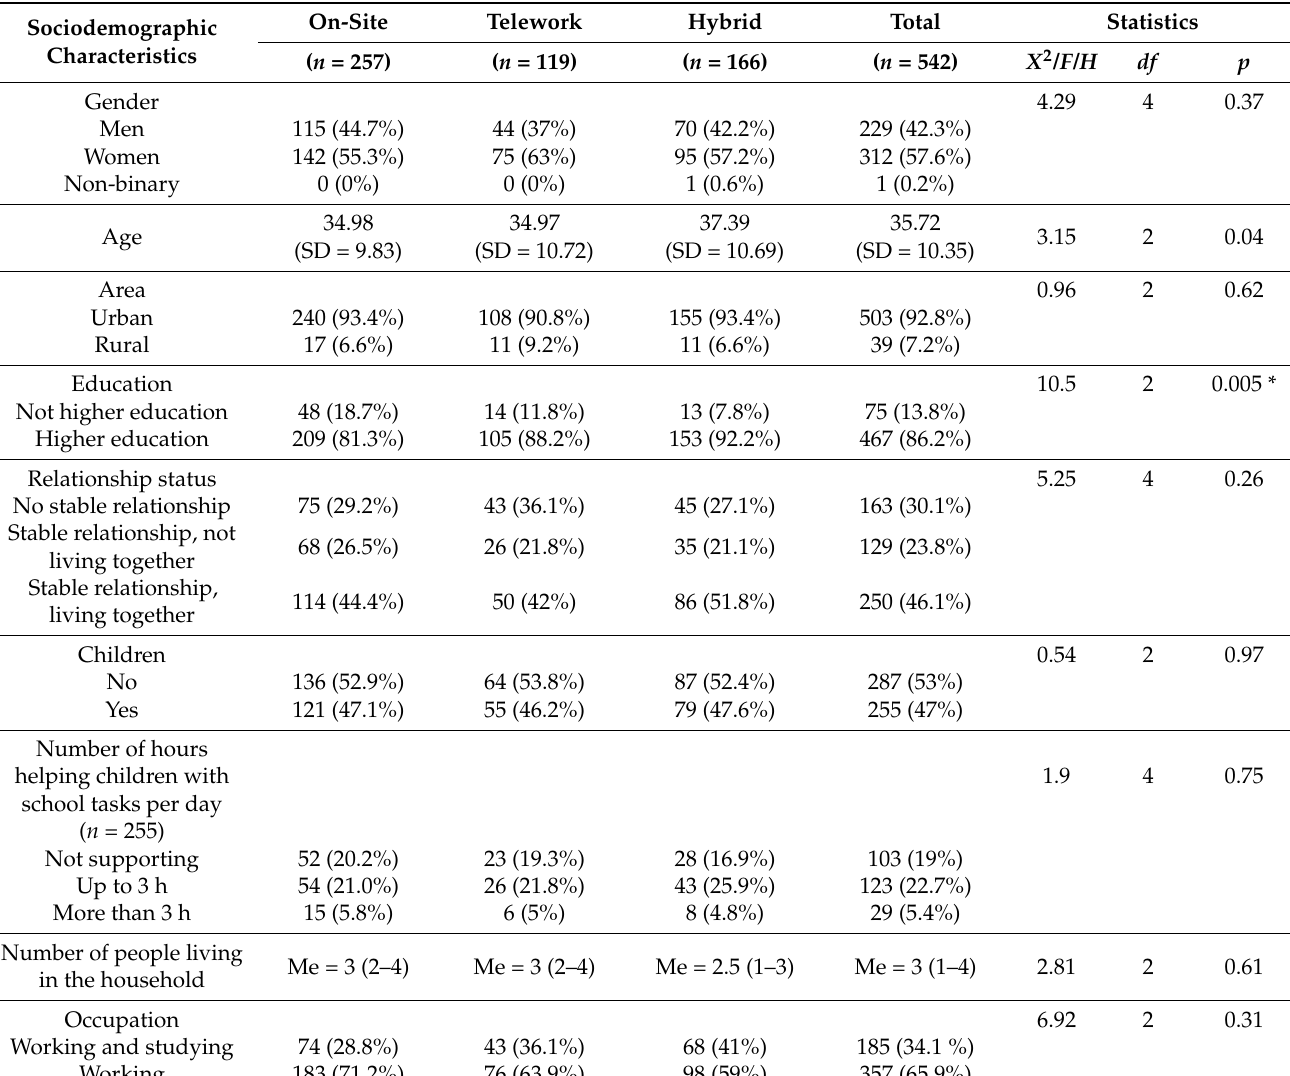
Table 1. Sociodemographic characteristics by working modality and comparison